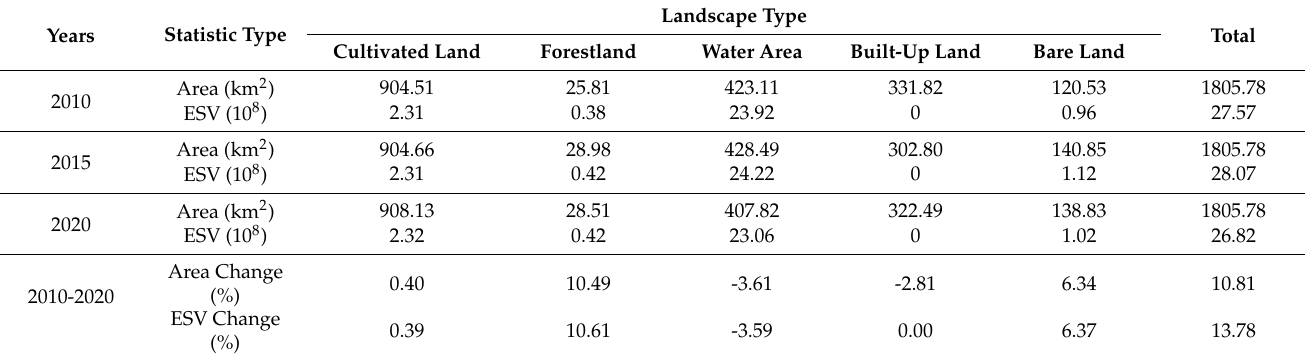
Table 5. Changes in landscape type and ESV in